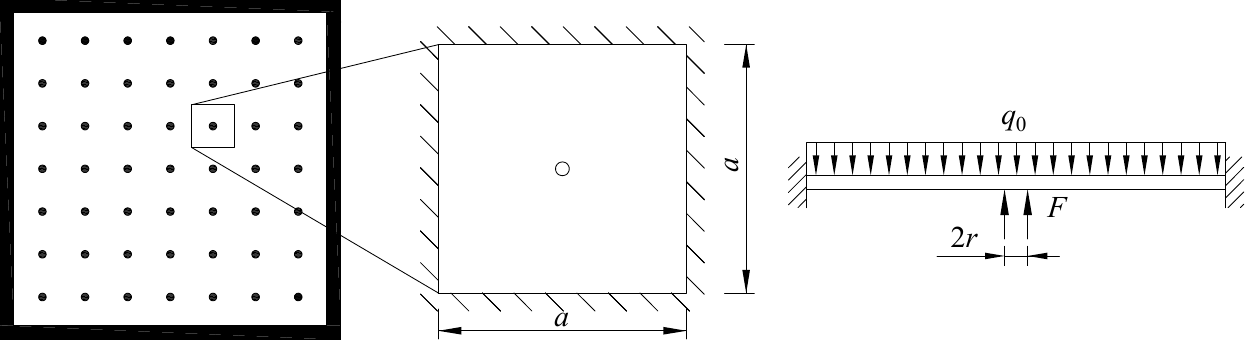
Figure 2. Simplified square unit and its force diagram. Where a is the pillar separation of the square unit, q 0 is the atmospheric pressure, r is the supporting pillar radius and F is the support force from the supporting pillar.